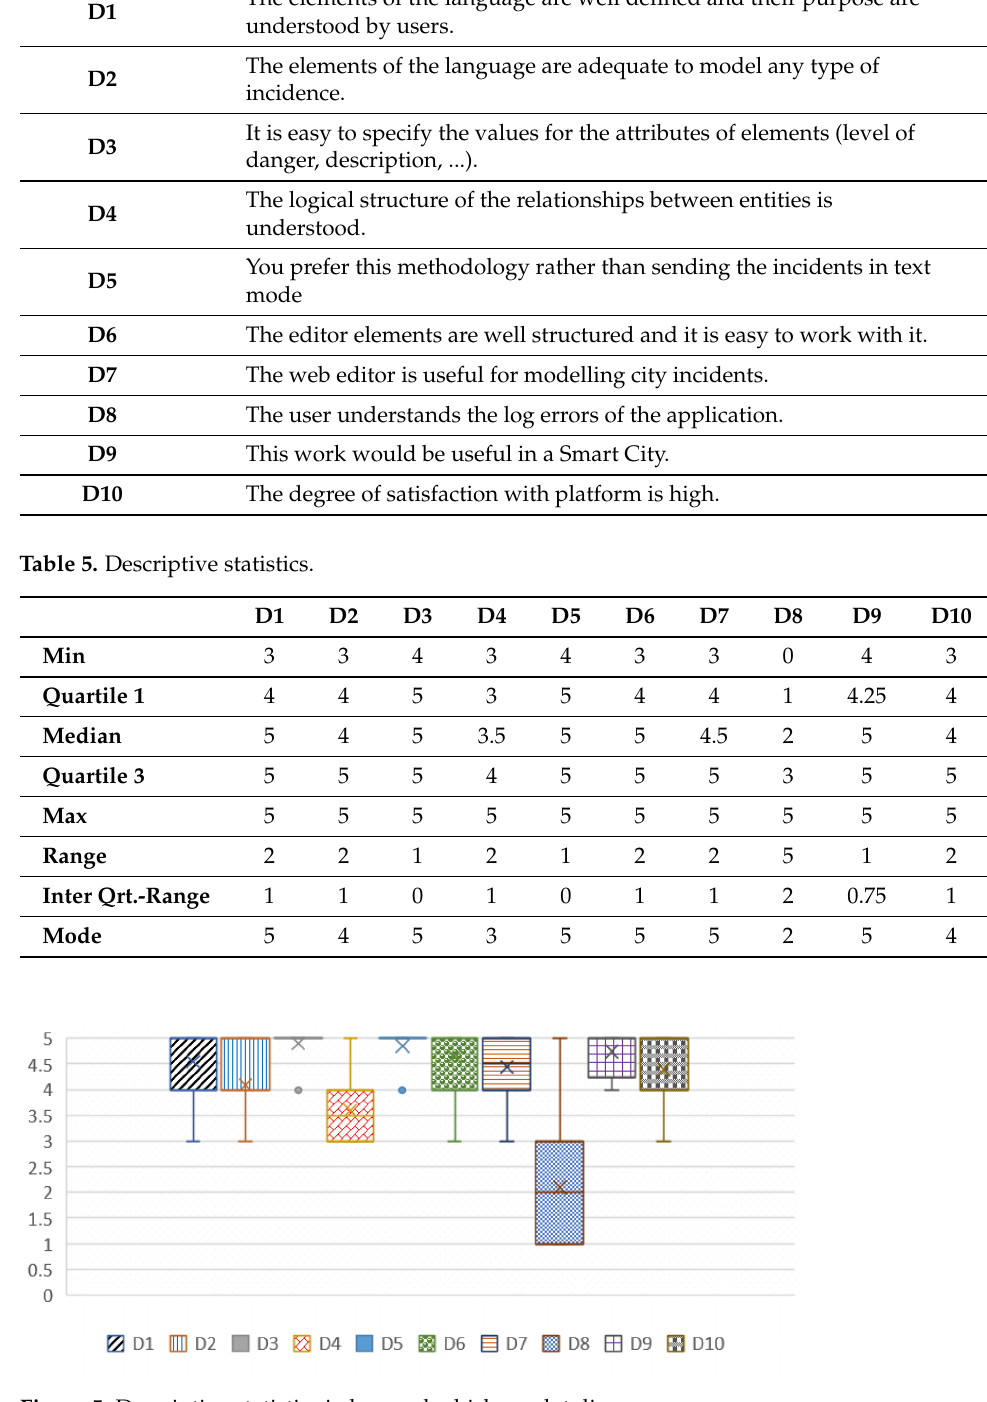
Figure 5. Descriptive statistics in box and whiskers plot